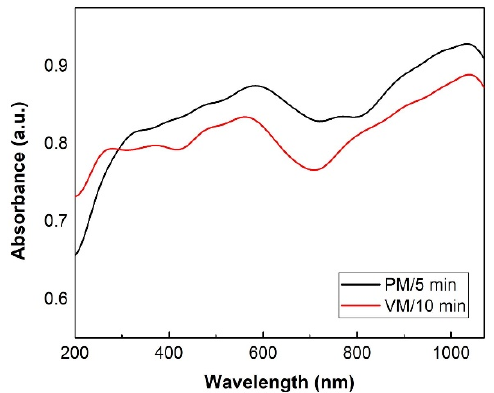
Figure 8. UV–Vis optical absorption spectra of CuSe products after 5 and 10 min of mechanochemical synthesis, in planetary (PM) and vibratory mills (VM).